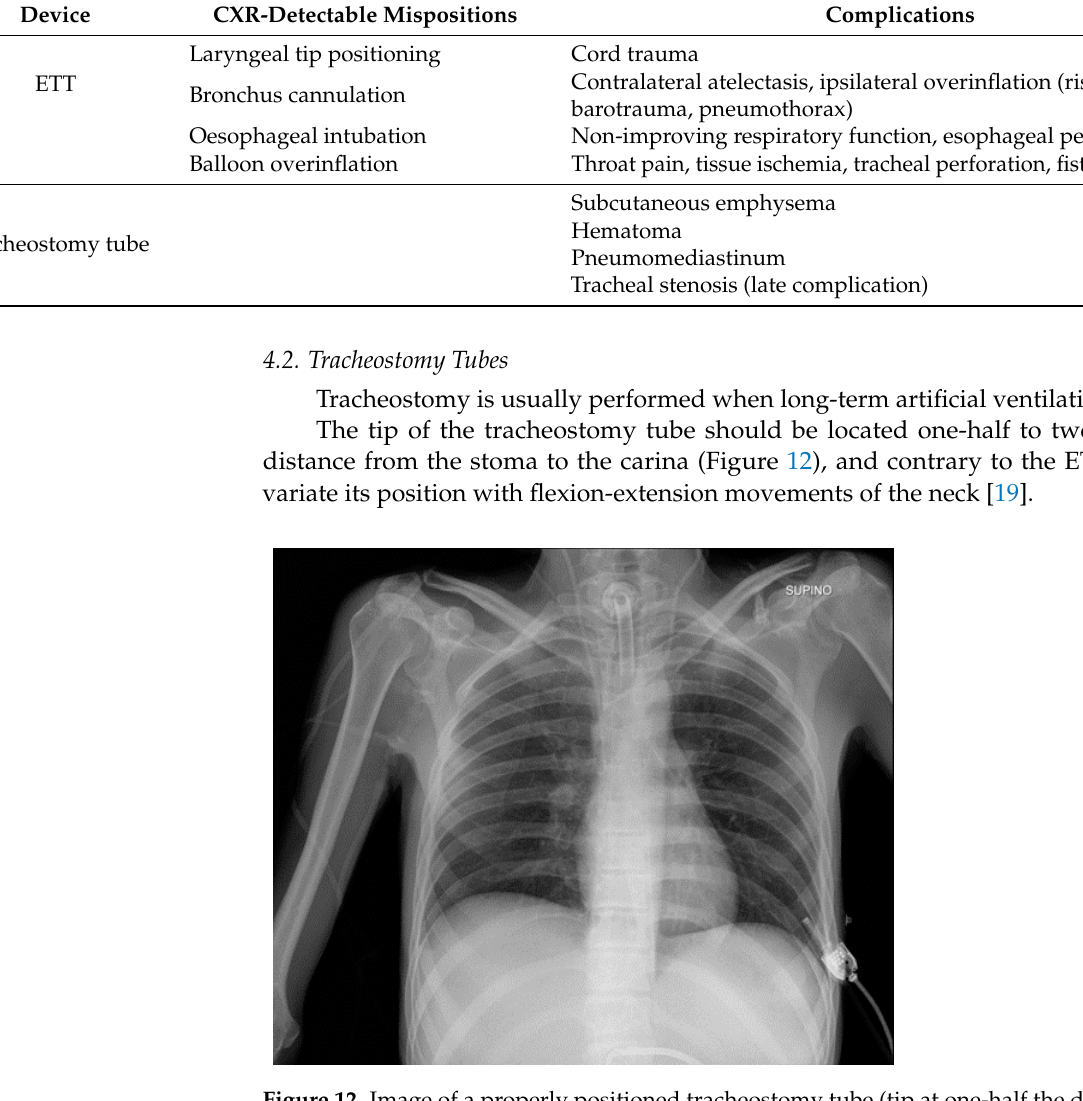
Figure 12. Image of a properly positioned tracheostomy tube (tip at one-half the distance from the stoma to the carina); the CXR also shows right and left jugular CVCs.